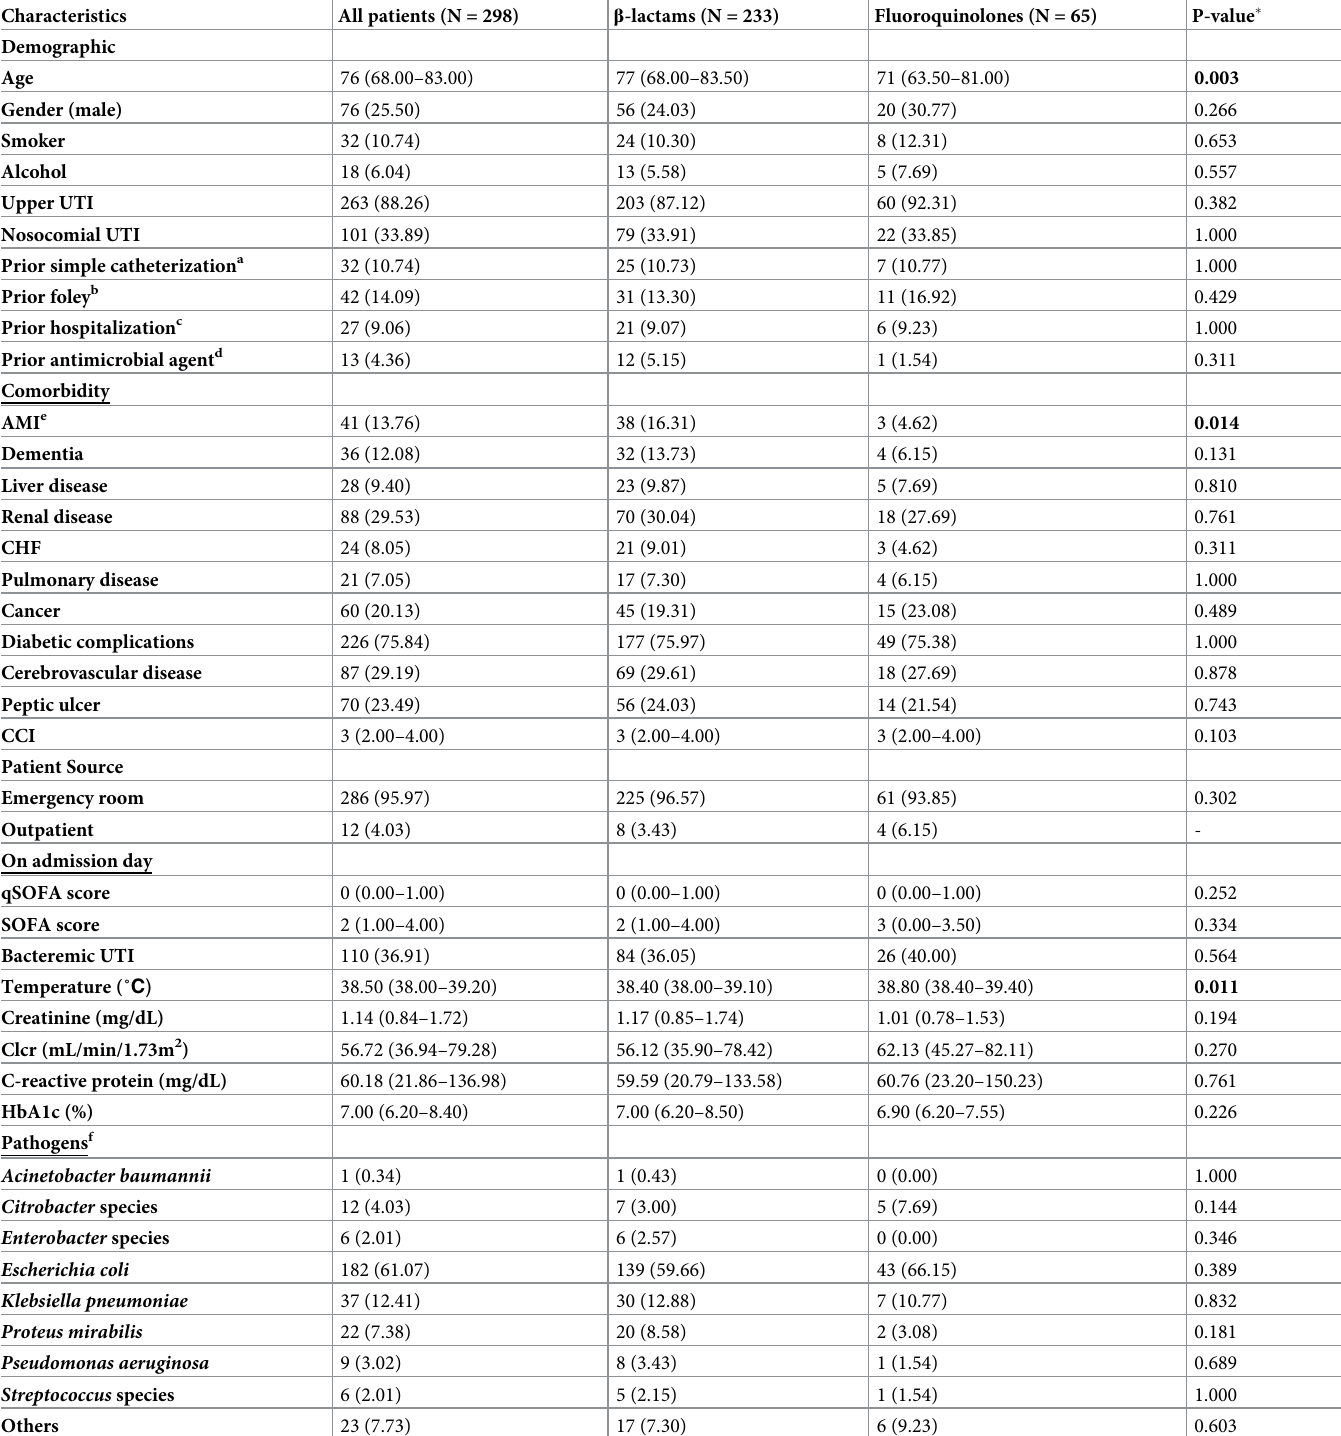
Table 1. Patients